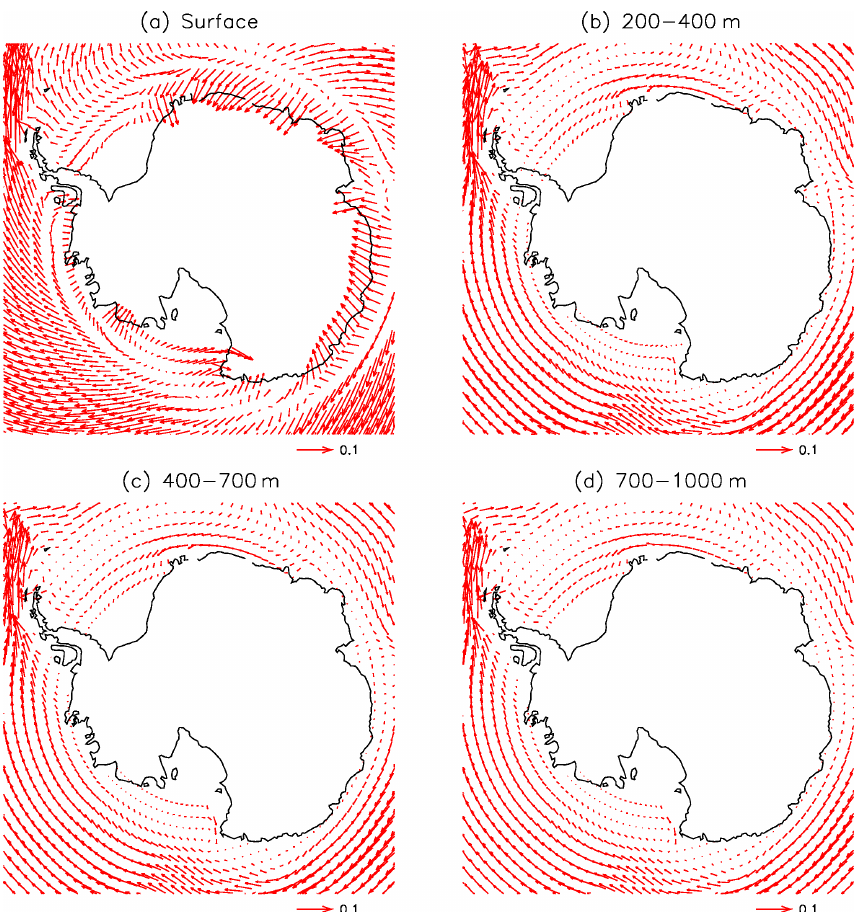
Figure 6. Climatological annual-mean ocean velocities (ms − 1 ) for the pre-industrial control simulation: (a) surface velocity, (b) mean velocity at a depth of 200–400m, (c) mean velocity at a depth of 400–700m and (d) mean velocity at a depth of